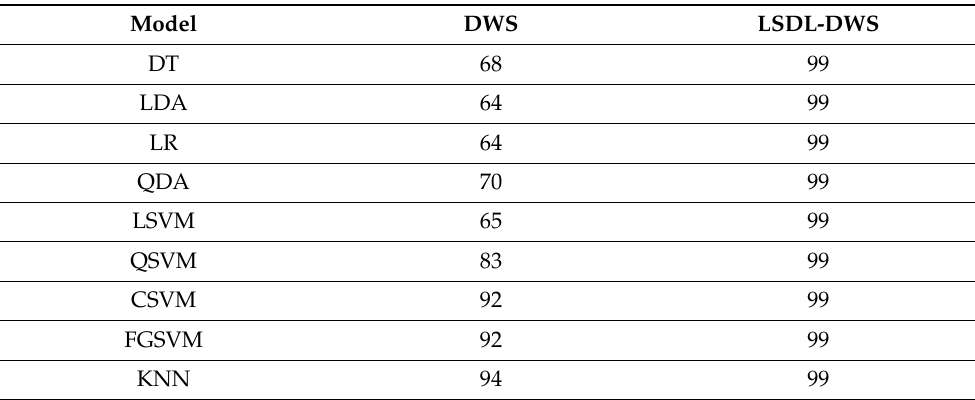
Table 2. Results of the FHR